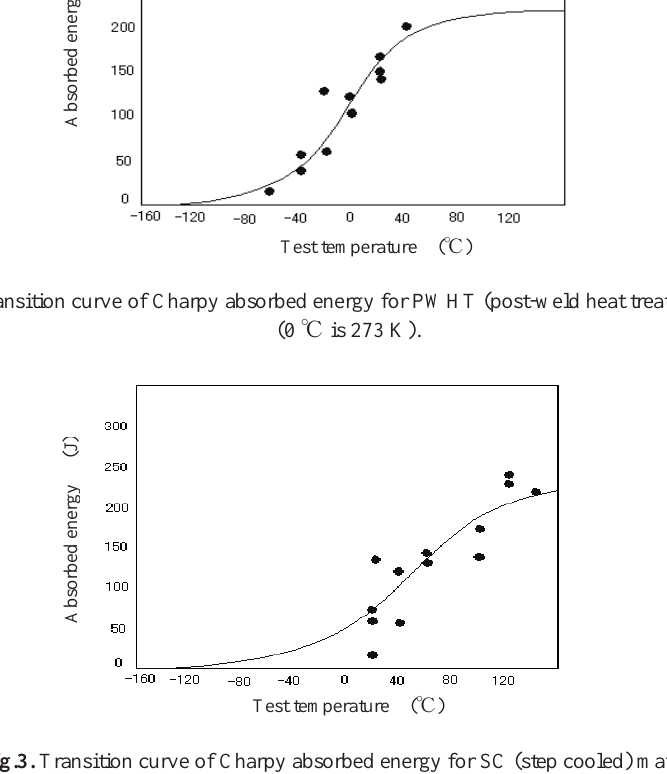
Fig.3. Transition curve of Charpy absorbed energy for SC (step cooled) material. (0 (cid:864) is 273 K).